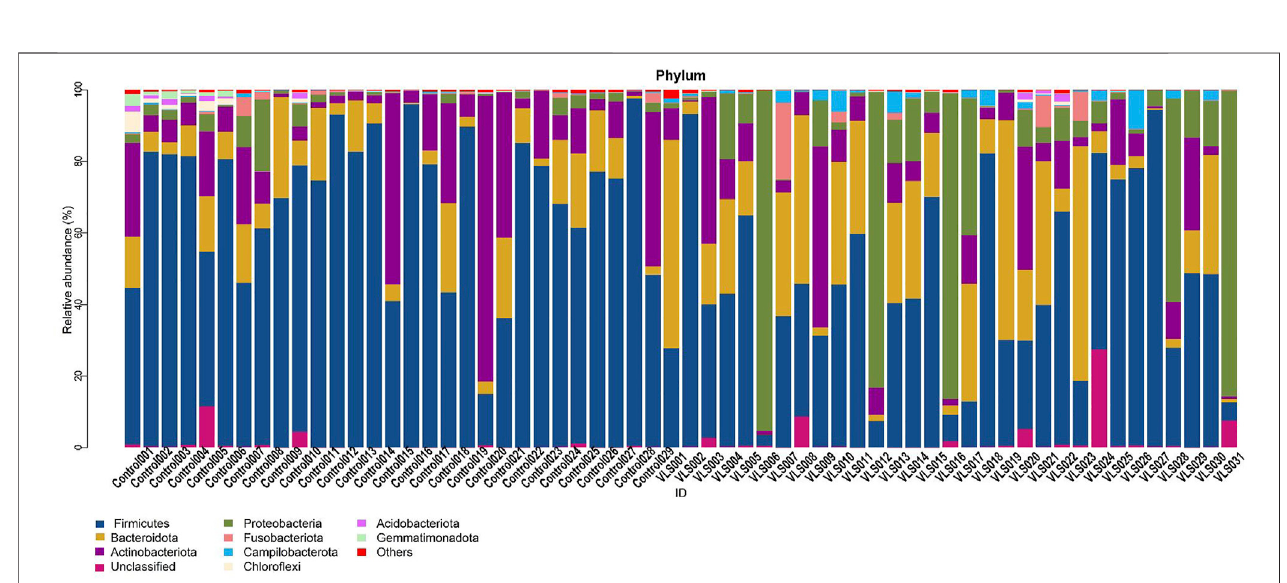
FIGURE 4 | Species ’ relative abundance map at the phylum level of the VLS and control groups.